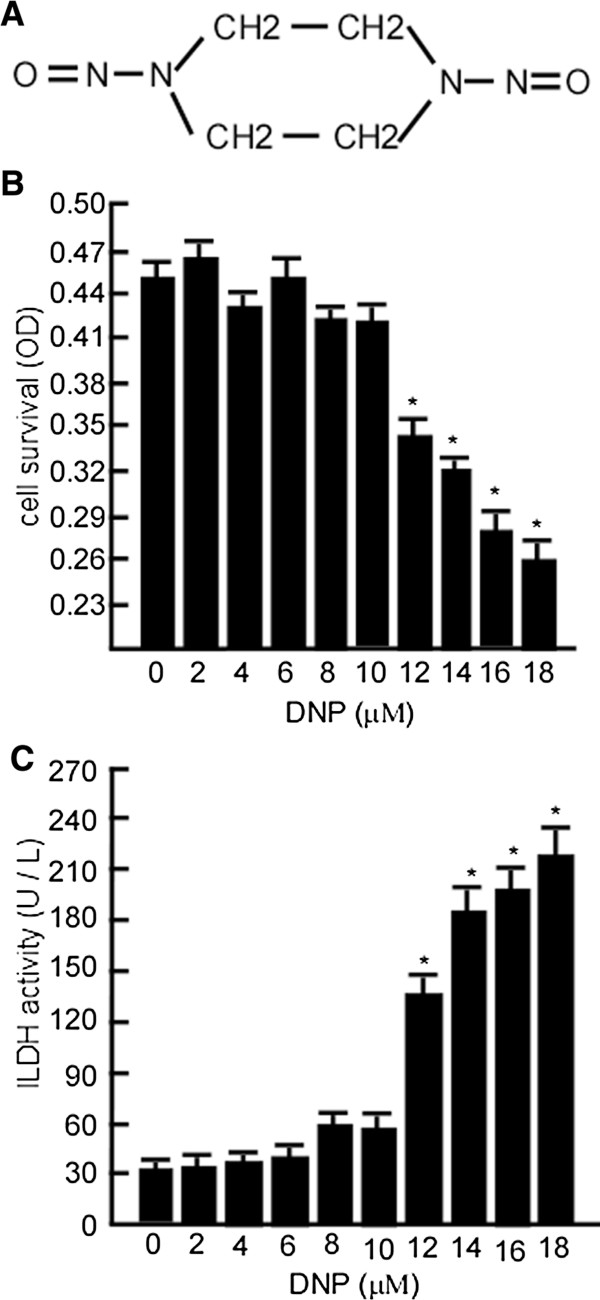
Non-cytotoxic concentration of DNP in stable isotope-labeled 6-10B cells.A, Structure of DNP, an N-nitroso compound. B, Stable isotope-labeled 6-10B cells were treated with the indicated DNP concentration and then subjected to MTT cell viability assay as described in the Materials and Methods. “OD” indicates the relative optical density at 492 nm. C, After stable isotope-labeled 6-10B cells were treated with the indicated DNP concentration, and cell media were subjected to the LDH assay. LDH activity is per 1 L of media. Data are presented as the means ± standard deviation from three independent experiments, statistically analyzed using Student’s t- test (*, p < 0.05; α=0.05).